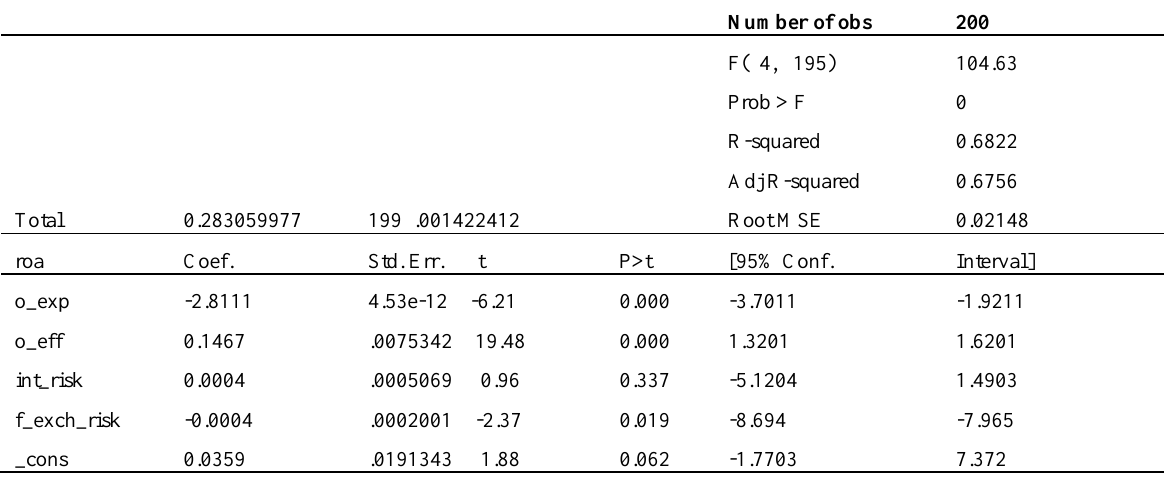
Table 5: Effect of Operational and Market Risk Exposures on Financial